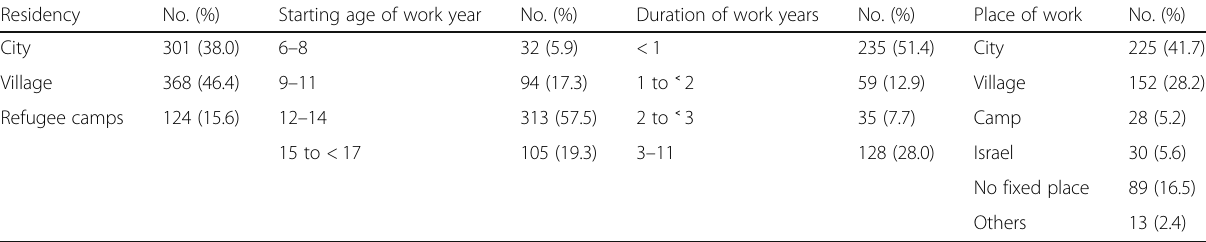
Table 1 Socio-demographic characteristics of the